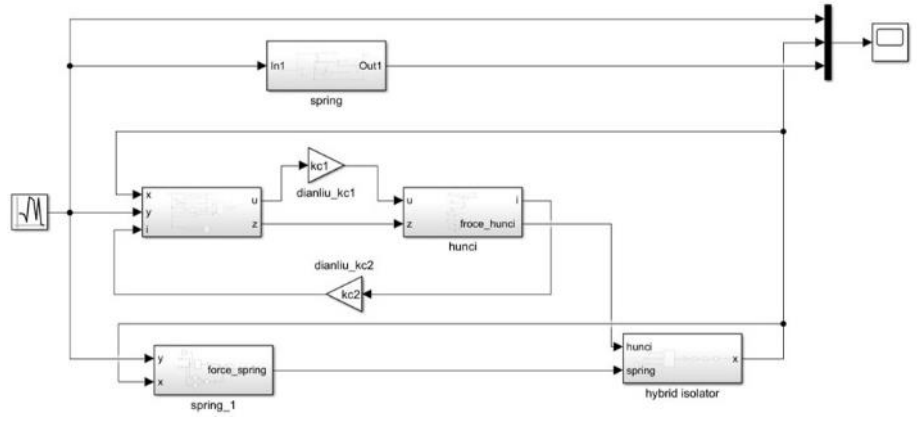
Figure 12. The Simulink model.